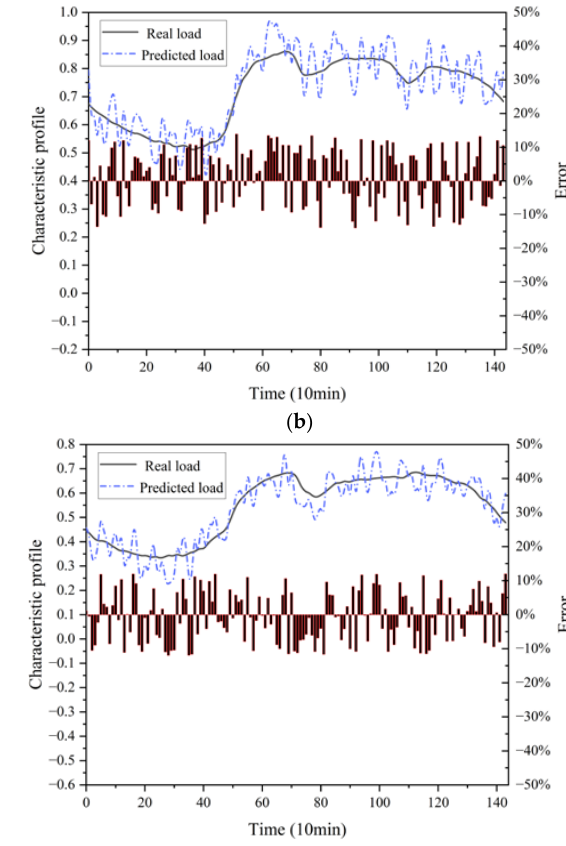
Figure 7. The prediction results and deviations of PV on four typical days. ( a ) Spring; ( b ) Summer; ( c ) Autumn; ( d ) Winter.